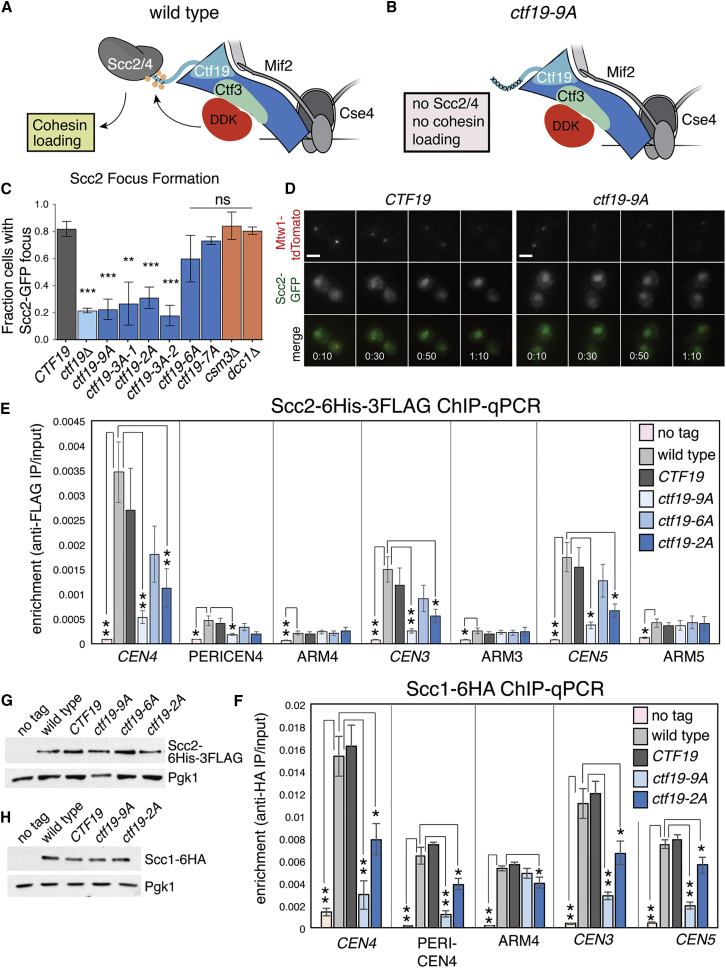
Ctf19 Phosphorylation Is Required for Scc2 Localization at Centromeres(A and B) Model for the mechanism of Scc2/4 (gray) recruitment by the Ctf19 complex (blue) and DDK (red). Ctf3 is shown in green, and phosphate modifications are depicted as yellow circles. (A) Ctf3 recruits DDK, which phosphorylates Ctf19 to provide a docking site for Scc4. (B) Cells lacking the Ctf19 phosphorylation sites lack the Scc4 docking site, despite normal DDK recruitment.(C and D) Ctf19 phosphorylation is required for efficient localization of Scc2 to centromeres. Strains of the indicated genotypes expressing Scc2-GFP and Mtw1-tdTomato (SMH353, SMH361, SMH354, SMH355, SMH451, SMH452, SMH459, SMH460, SMH416, and SMH417 listed in the order shown) were imaged during unperturbed vegetative growth and scored for the presence of centromeric Scc2-GFP foci. Values are the averages of at least three independent experiments. At least 25 cells were scored per strain per experiment (error bars, +/−SD for the independent experiments; ∗∗∗p < 0.001; ∗∗p < 0.01; ns, not significant; Student’s t test versus CTF19 strain, two tails, unequal variance). (D) Representative images from experiments quantified in (C) (scale bar, 3 μm). Time after the beginning of image acquisition is shown.(E and F) Scc2 and Scc1 localization require Ctf19 phosphorylation. Cells were arrested in metaphase following treatment with nocodazole and benomyl for 2.5 hr (AM1176, untagged control strain). Values are means from four independent experiments (error bars, SE; ∗p < 0.05; ∗∗p < 0.01; Student’s t test for indicated comparisons, unpaired, two-tails). (E) ChIP-qPCR for Scc2 performed using wild-type (AM6006), CTF19 (AM20613), ctf19-9A (AM20619), ctf19-6A (AM20622), and ctf19-2A (AM21908) cells, carrying SCC2-6His-3FLAG. (F) ChIP-qPCR for Scc1 performed using wild-type (AM1145), CTF19 (AM20629), ctf19-9A (AM23456), and ctf19-2A (AM21958) cells, carrying SCC1-6HA.(G and H) Immunoblots showing levels of Scc2-6His-3FLAG, Scc1-6HA, and Pgk1 (loading control) from a representative experiment.